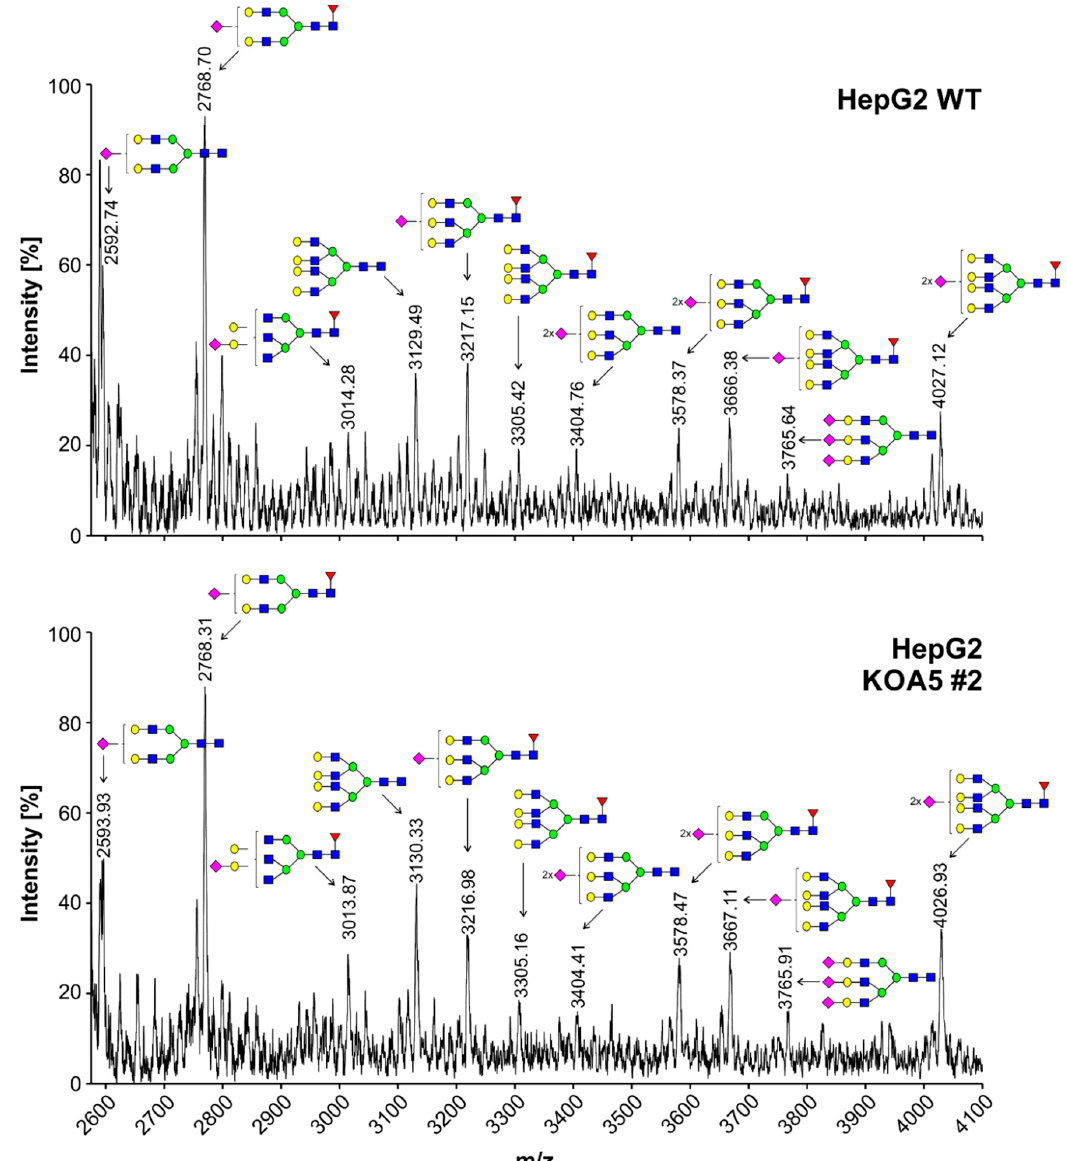
Figure 1. Structural analysis of N -glycans isolated from wild-type and solute carrier family 35 member A5 (SLC35A5)-deficient HepG2 cells. The 2-aminobenzamide (2-AB)-labeled and permethylated N -glycans derived from the appropriate cells were characterized using MALDI-TOF mass spectrometry. Blue squares, N -acetylglucosamine; green circles, mannose; yellow circles, galactose; red triangles, fucose; pink squares, sialic acid.